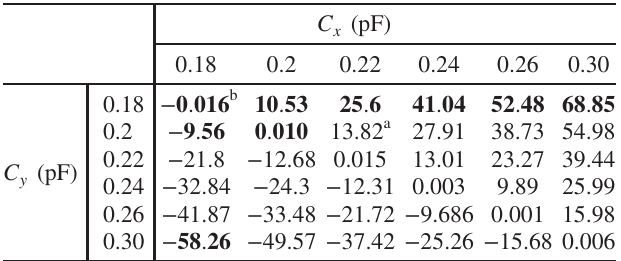
(degrees) for a y -polarized incident r